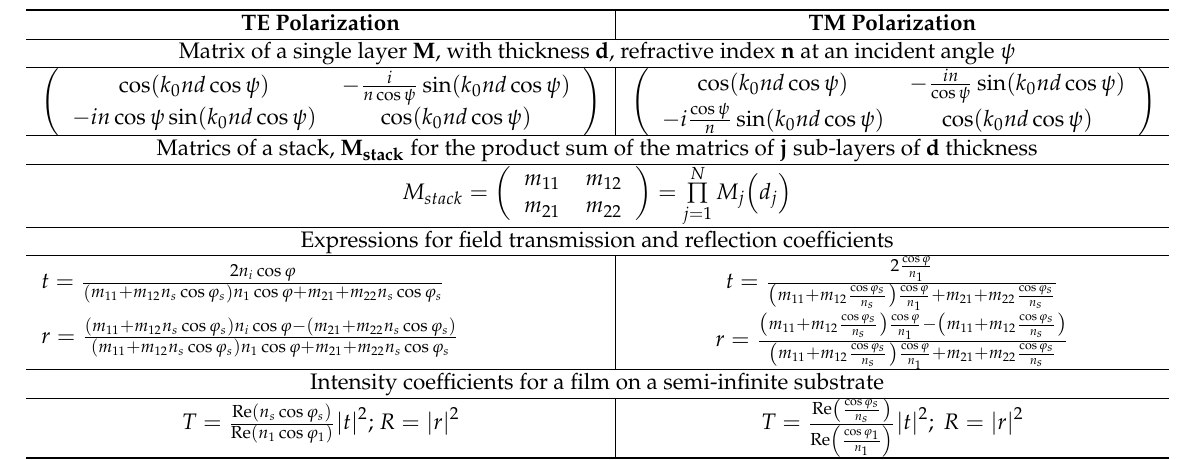
Table A1. Matrices used to calculate optimized Transmittance/reflectance. TE